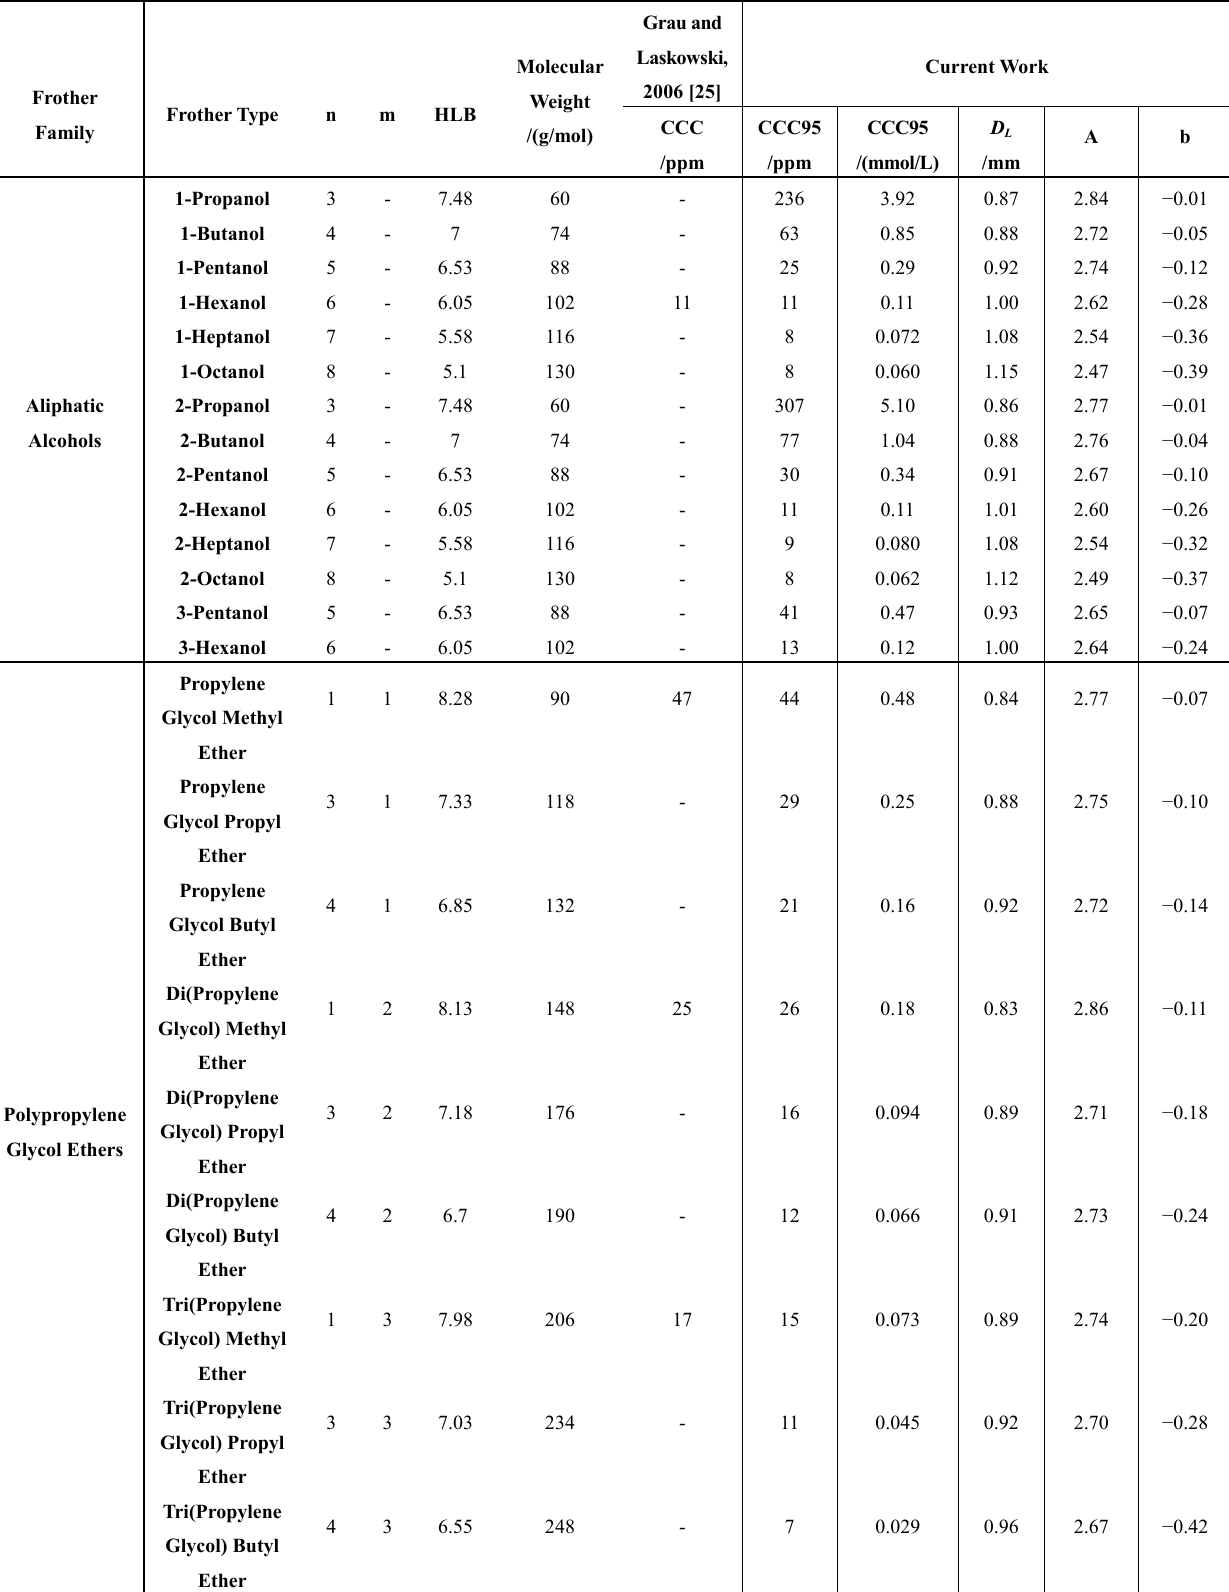
determined for the tested L